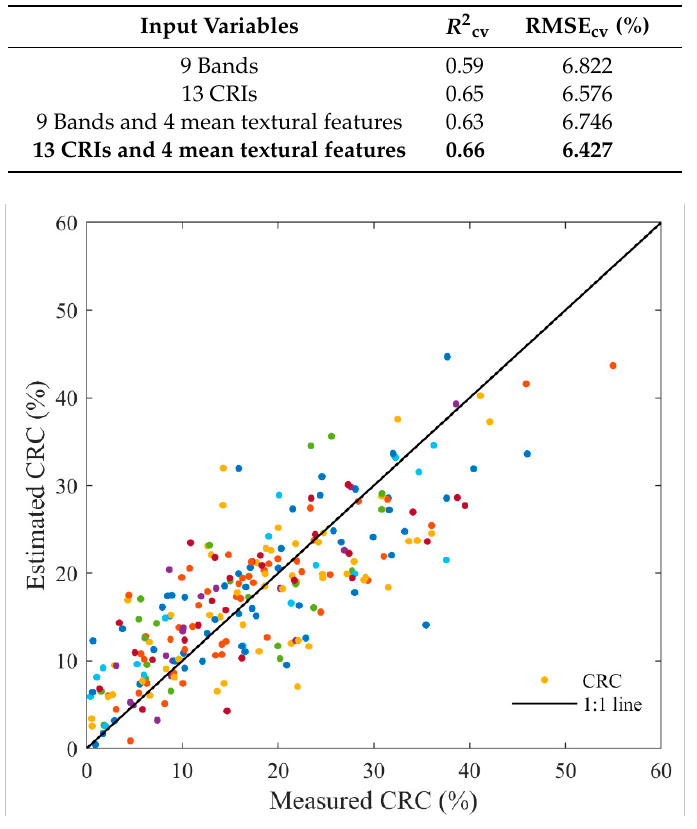
Figure 6. Measured vs. estimated CRC values along the 1:1 line of the best PLSR model (see Table 4). The different colors indicate the 10-fold subsets.